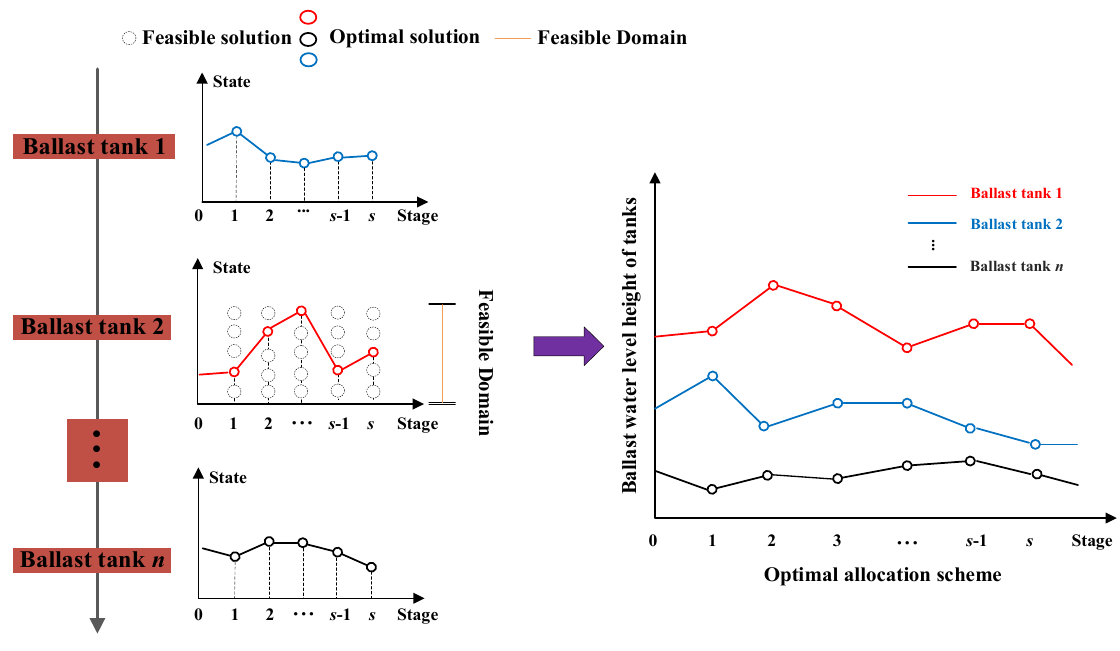
Figure 3. Dynamic programming solving strategy.